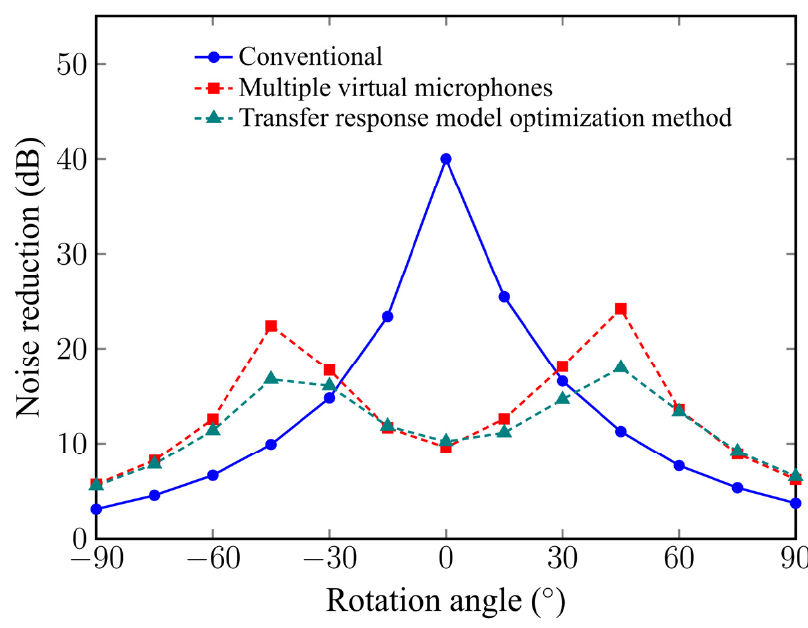
Figure 7. Noise attenuation of single channel system with two optimization methods when head rotates.